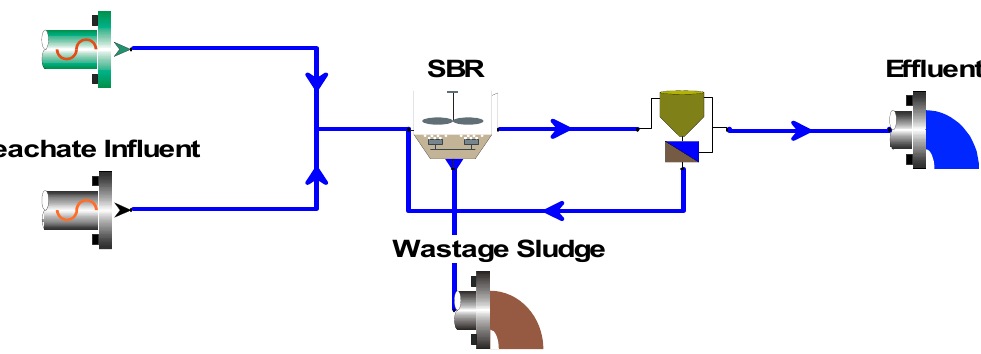
Figure 1. Schematic flow diagram for the leachate treatment plant as implemented in BioWin.